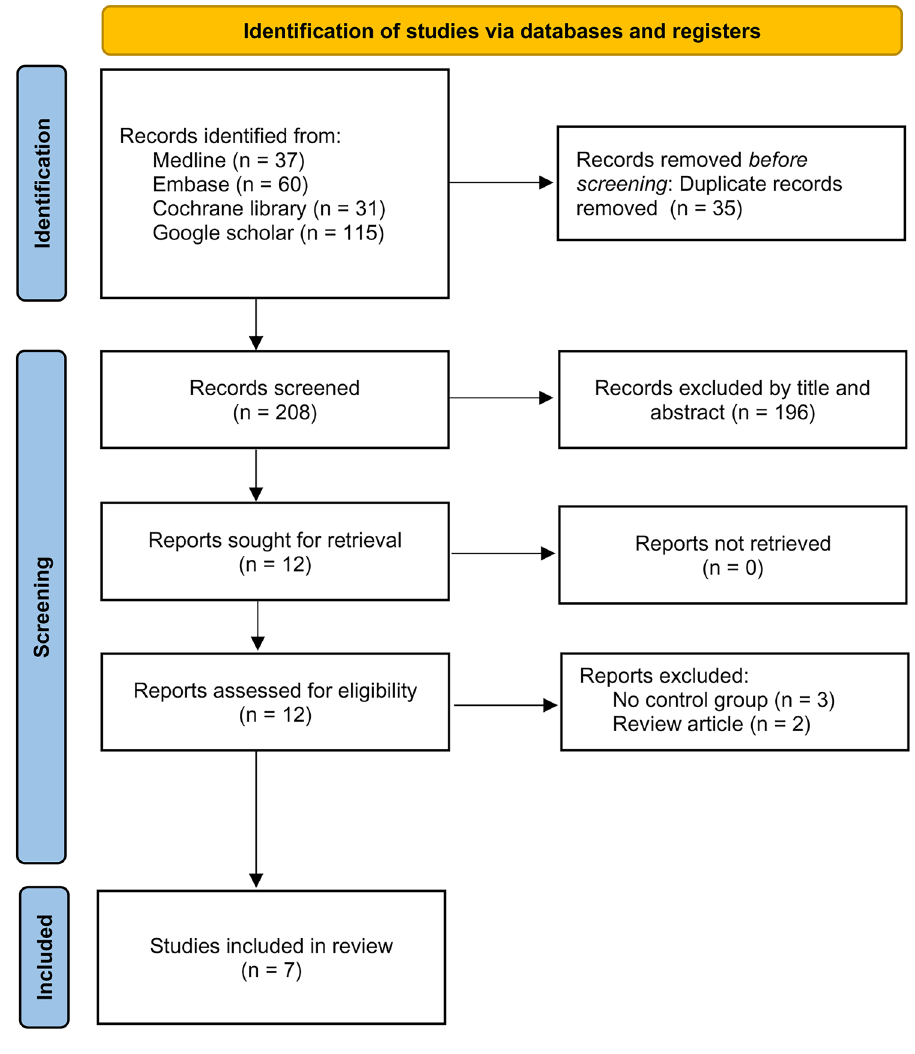
Figure 1. PRISMA flow diagram of study selection for the current